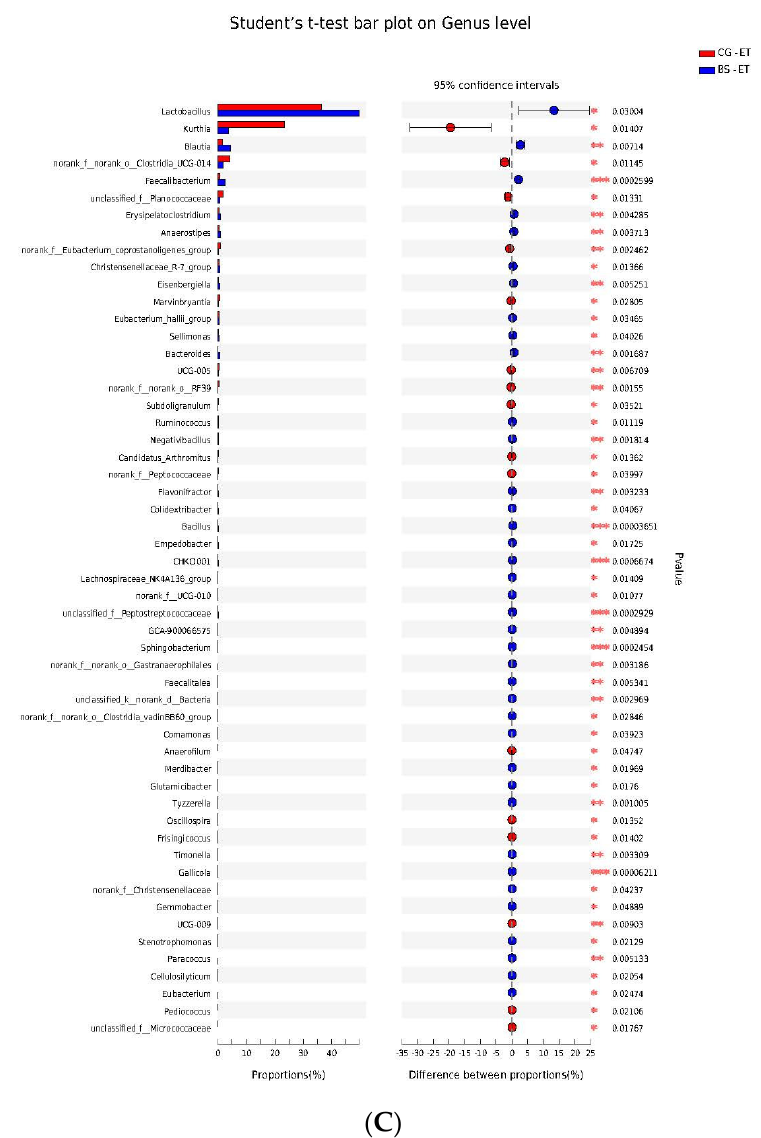
Figure 5. Microbial abundances enriched in treatments at genus level. ( A ) Enriched abundances of taxa at genus in groups CG − ET versus CG + ET comparison. ( B ) Enriched abundances of taxa at genus in groups CG + ET versus BS + ET comparison. ( C ) Enriched abundances of taxa at genus in groups CG − ET versus BS − ET comparison. *, **, *** represent significant difference.